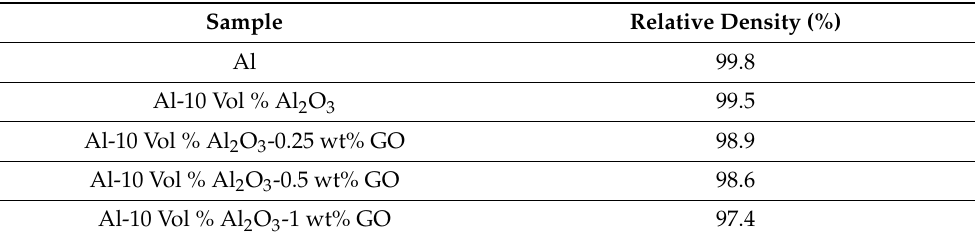
Table 2. Densification of all the sintered